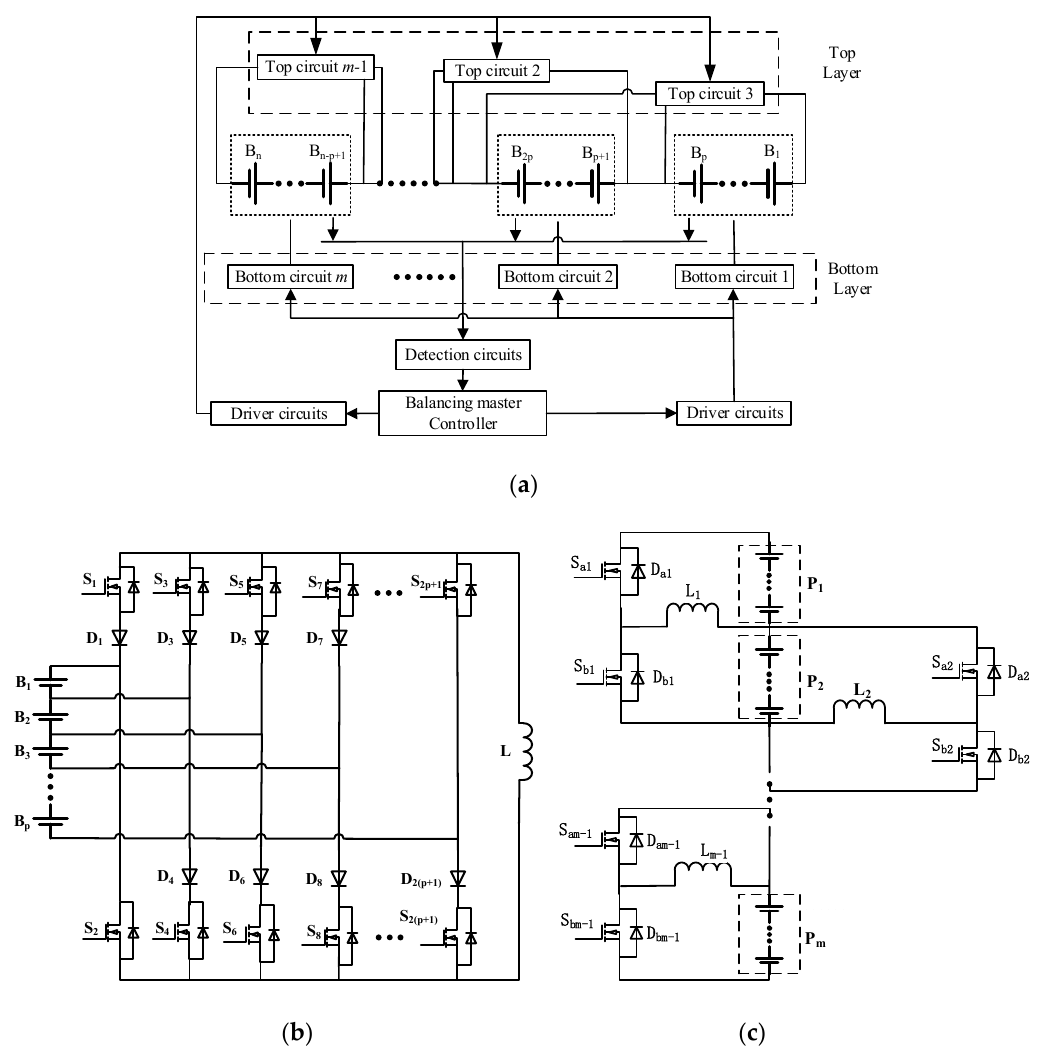
Figure 4. ( a ) Structure of the proposed bidirectional equalizer, ( b ) structure of bottom layer balancing circuit, ( c ) structure of top layer balancing circuit.